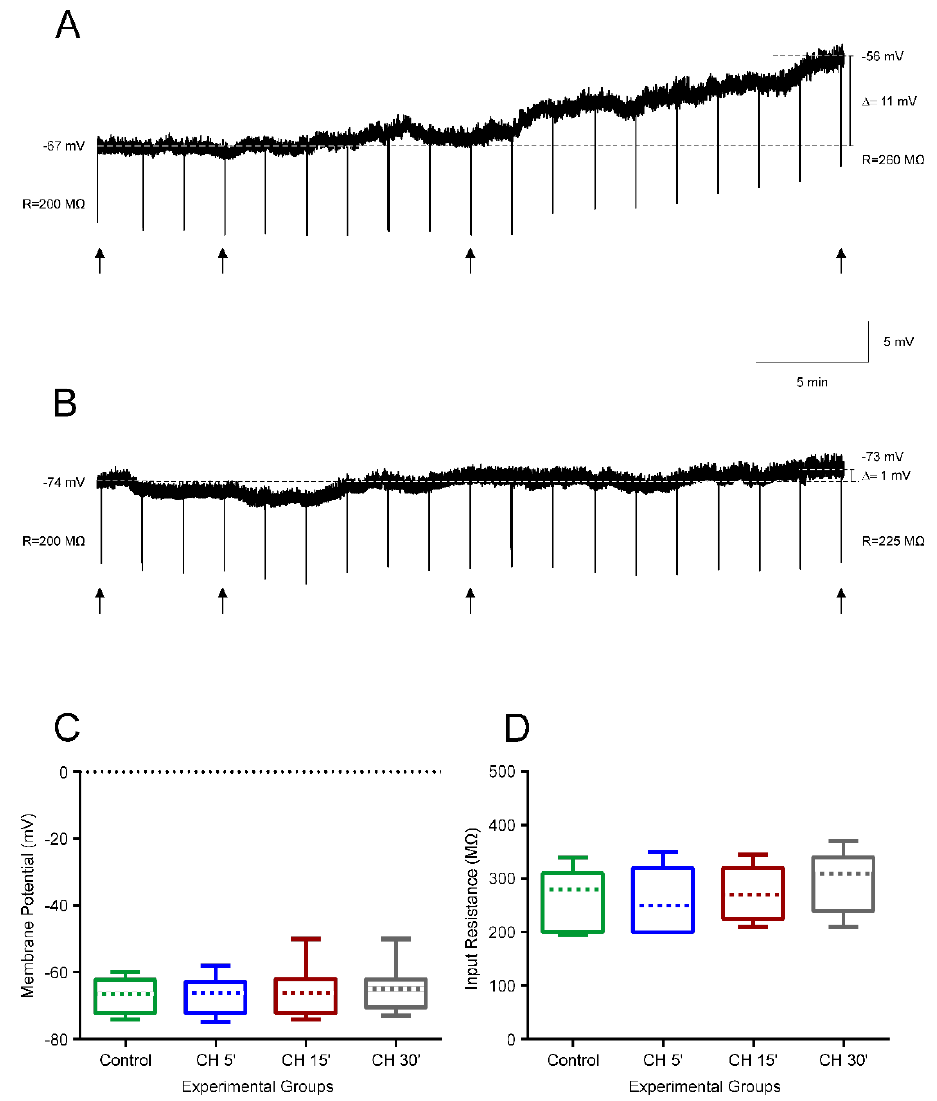
Figure 5. Prevention by glutathione monoethyl ester (GSH-MEE) of lipid peroxidation induced by cumene hydroperoxide (CH) on pyramidal neurons from the motor cortex in infantile rats. ( A , B ) Electrophysiological recording showing that the membrane potential depolarized and voltage response to negative current pulses of − 100 pA and 500 ms increased throughout 30 min exposure to CH 10 µ M ( A ) and remained stable ( B ) throughout 30 min exposure to CH 10 µ M plus GSH-MEE (4 mM). Arrows indicate the voltage response at 5, 15, and 30 min. C,D. Box-and-whisker plot illustrating the medians (dashed lines), interquartile ranges (boxes), and minimum / maximum values (whiskers) of the membrane potential ( C ) and input resistance ( D ) in the control situation and 5, 15, and 30 min after CH exposure in slices preincubated with GSH-MEE ( n =